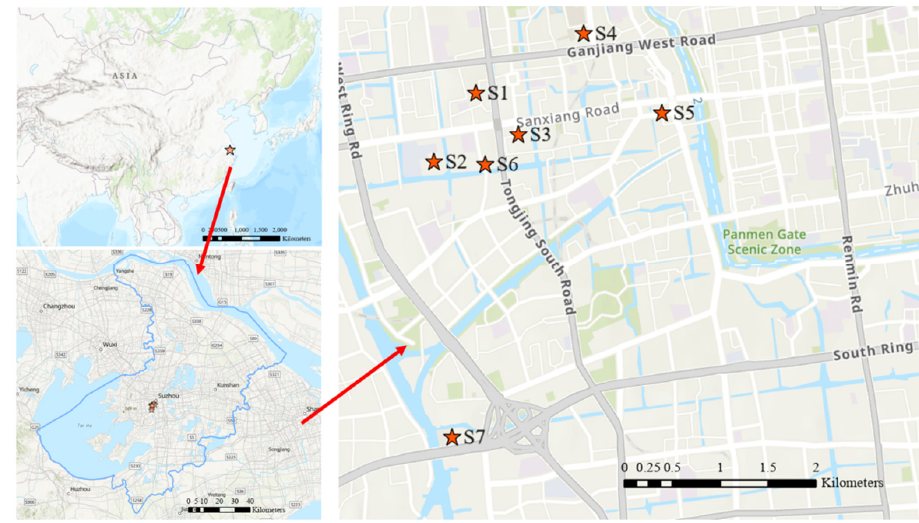
Figure 4. Sampling locations, represented as stars labeled from S1 to S7.